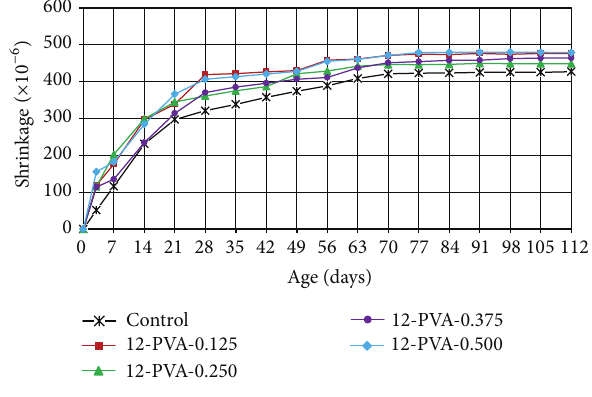
Figure 8: Shrinkage of 12 mm PVA-FRC and control.